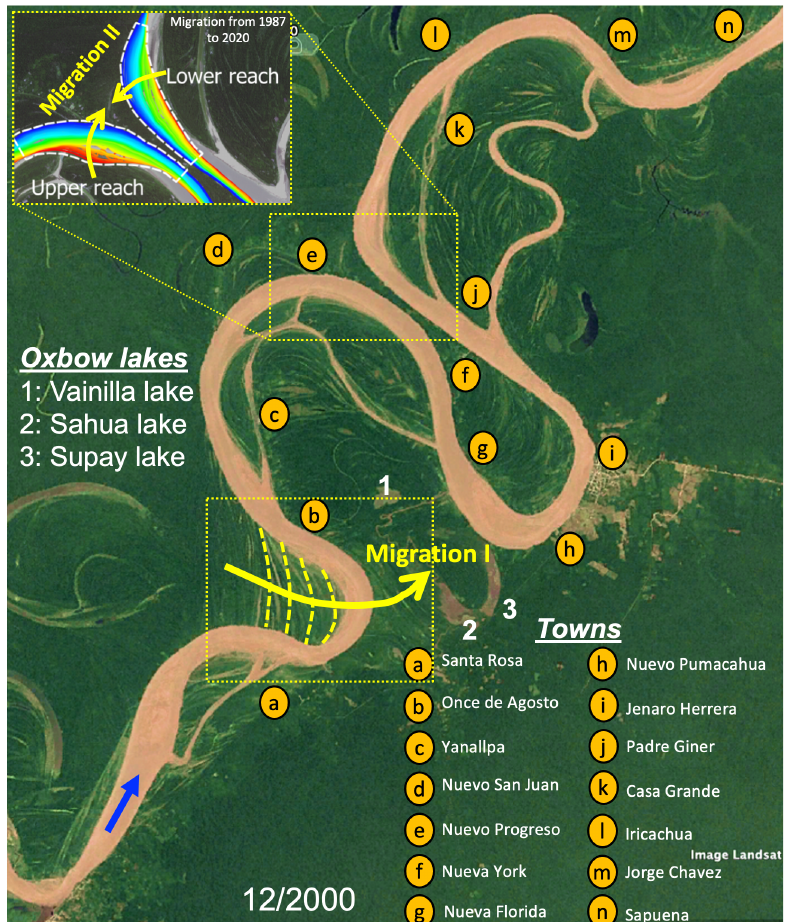
Figure 14. Towns (the location of towns were obtained from https://fishbrain.com/ (accessed on 30 June 2022)), paleochannels and oxbow lakes surrounding Jenaro Herrera town. Notice that during the last years, two preferential migration directions are observed (Migration I: to merge into paleochannels and oxbow lakes, Migration II: to produce a neck